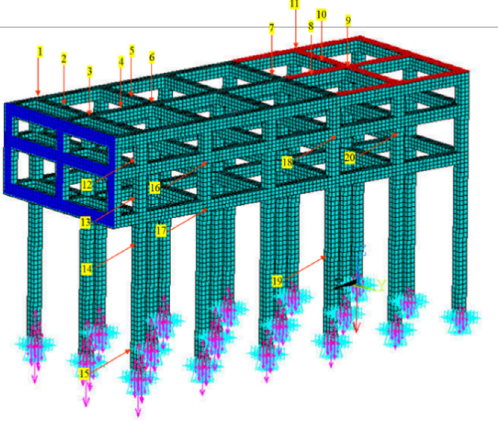
Figure 4. Schematic diagram of the load positions and response points positions of the wharf frame.